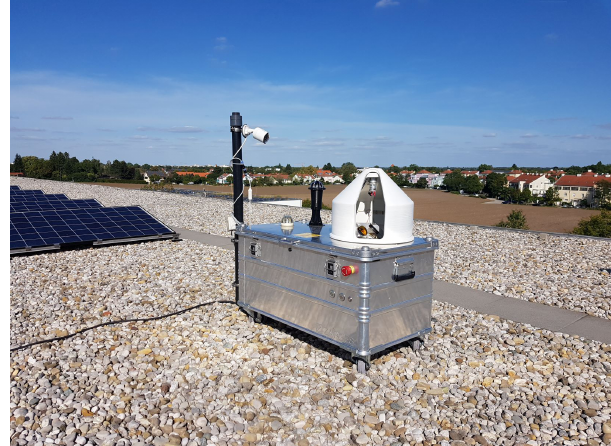
Figure 5. Image of the new enclosure system on the roof of a school at our southern site, Taufkirchen. The systems includes, inter alia, the newly designed rotating cover, the lightweight aluminum case, the solar radiation sensor and a surveillance camera attached to a